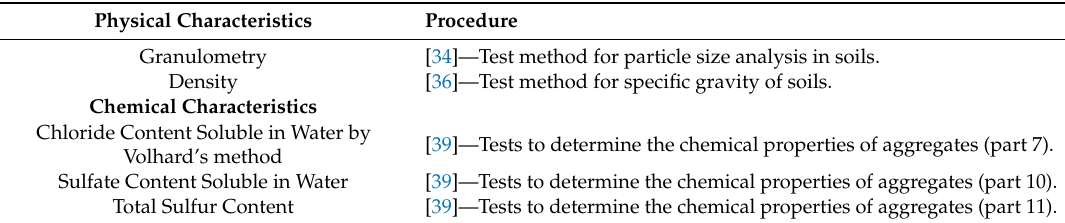
Table 2. Characterization of construction waste (6.3